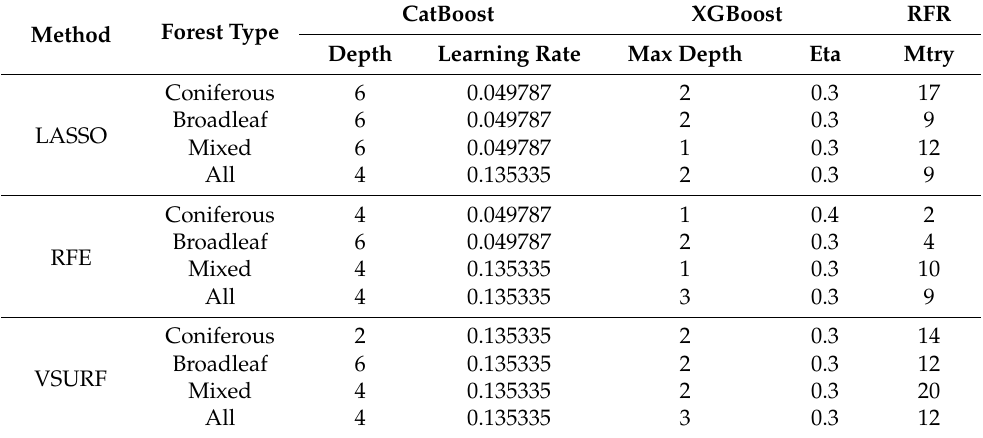
Table A1. Optimal hyperparameter using a grid search with 10-fold CV for the different AGB